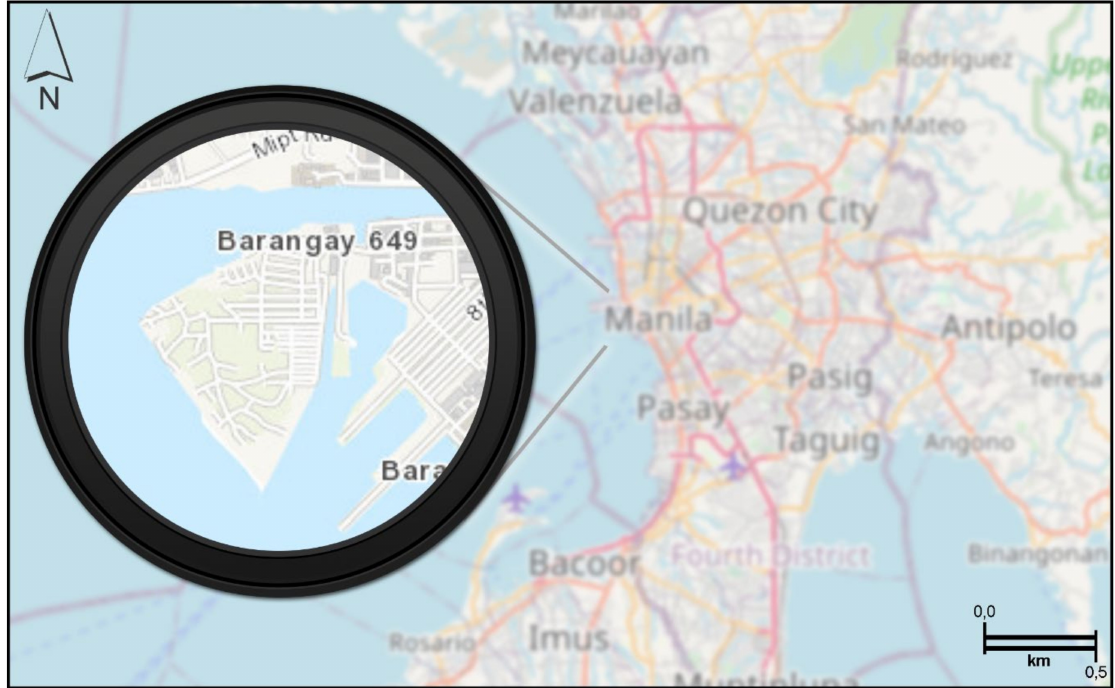
Figure 2. BaSECo informal settlement (Barangay 649), in the frame of the metropolitan city of Manila. Basemap source: Open Street